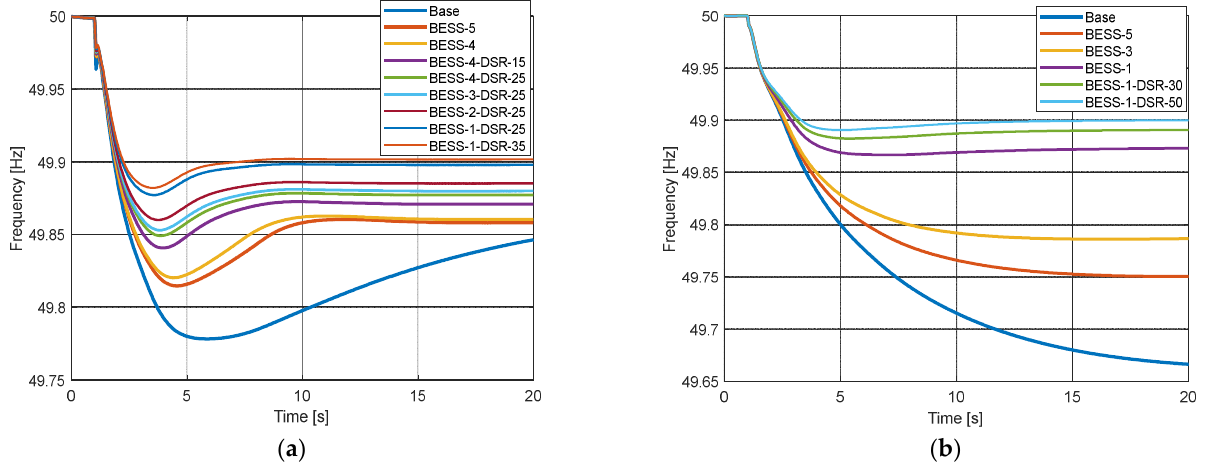
Figure 9. Frequency profiles for: ( a ) High Import DP, generation outage of 817 MW: ( b ) Lines out of service DP, 500 MW load-step in continental Italy.